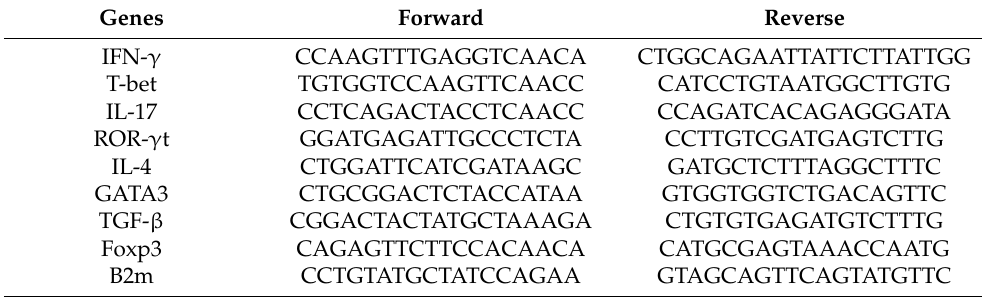
Table 1. Sequences of primers that were used in the